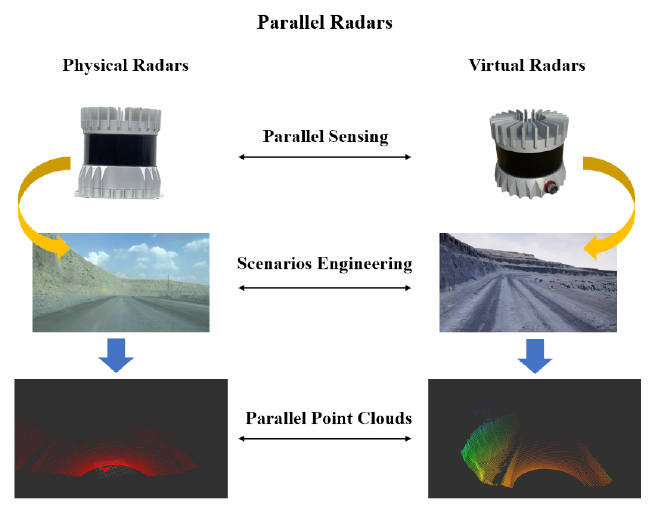
Figure 8. Application of Parallel Radars in